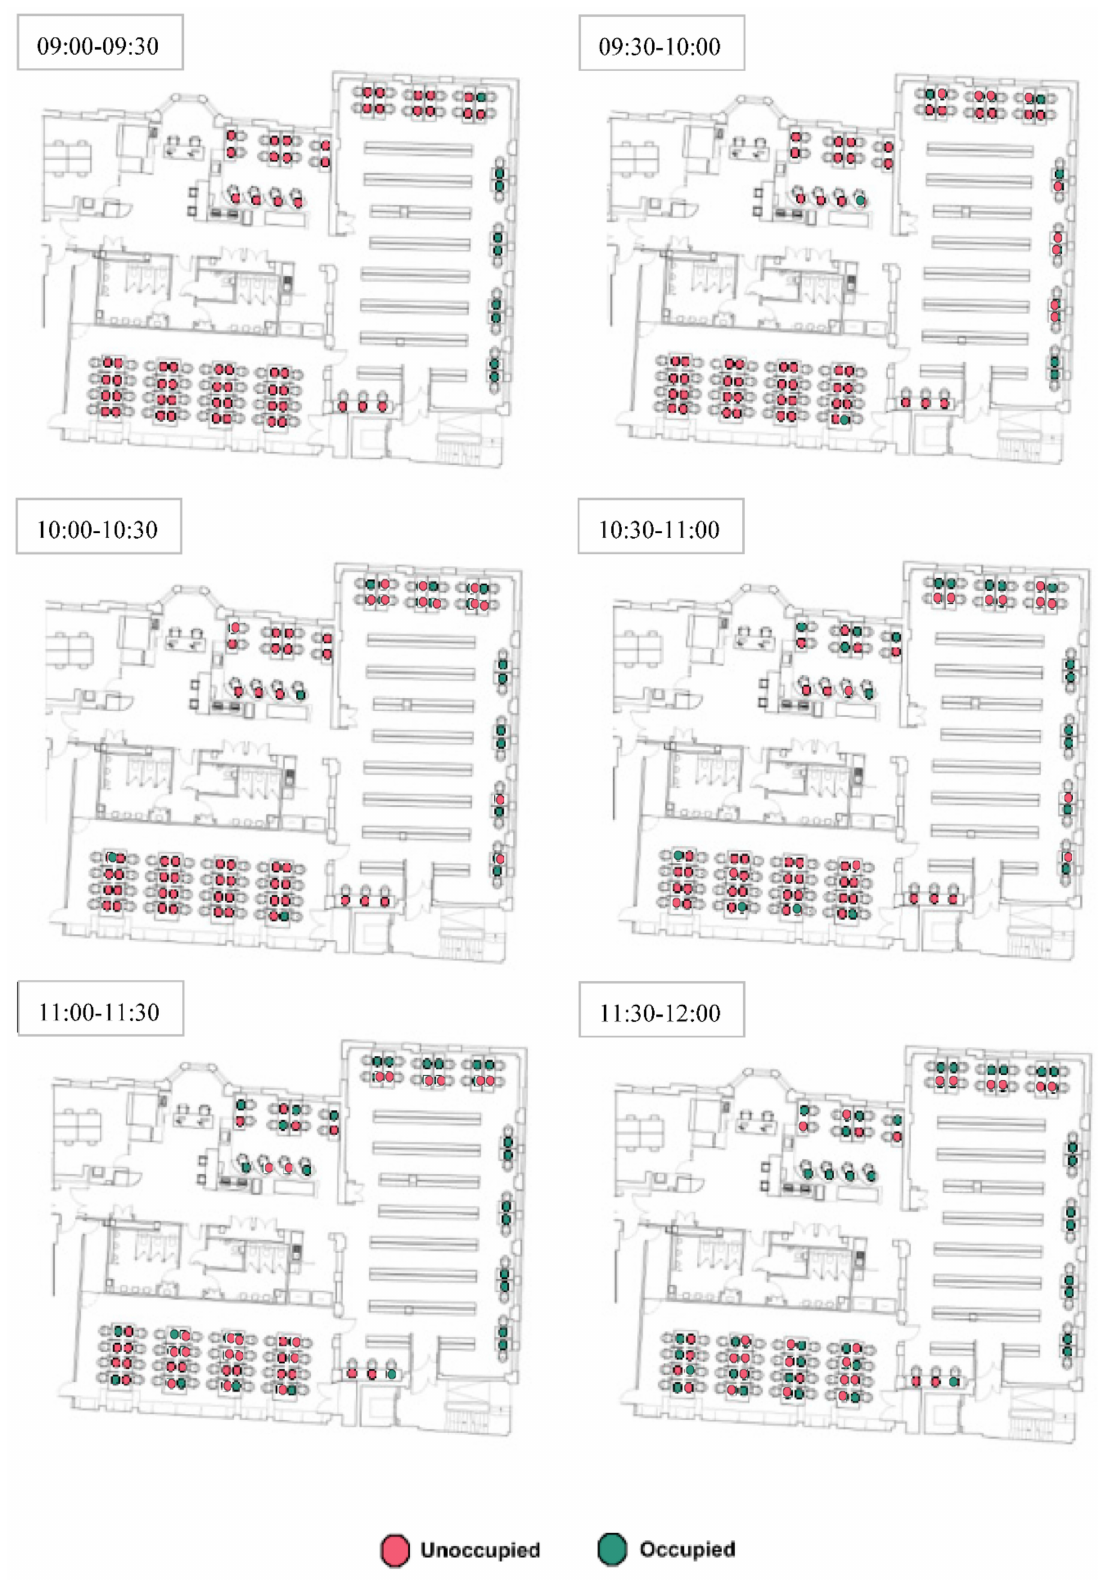
Figure 7. Seating preferences of the students in the early hours after